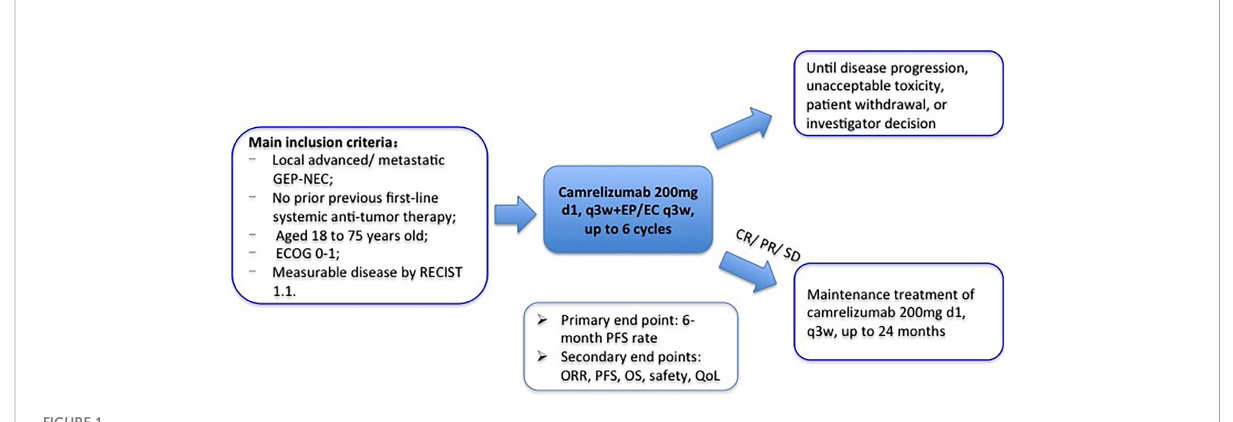
FIGURE 1 Outline of the study